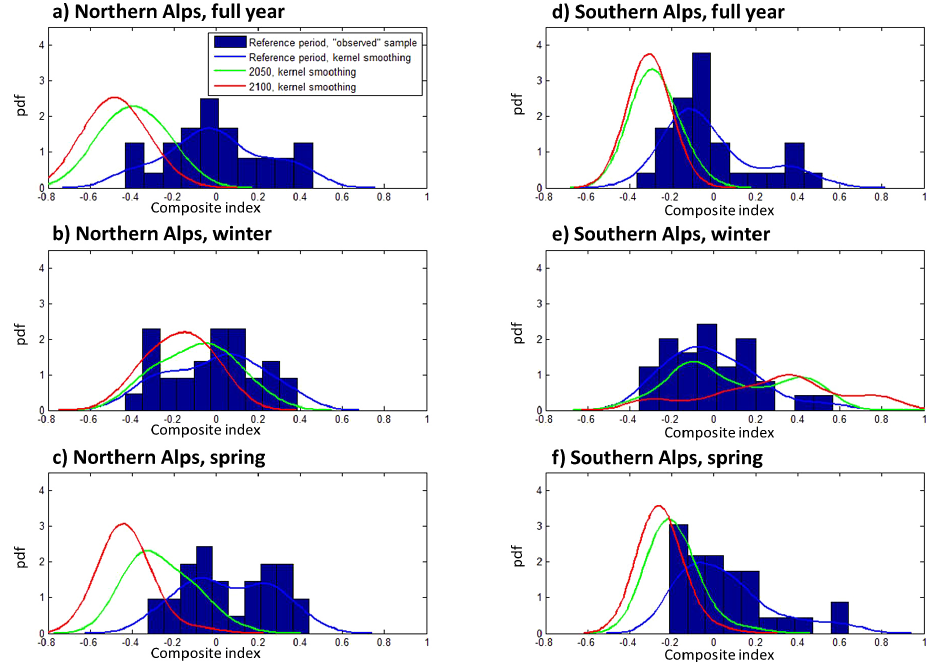
Figure 9. Probability density functions of the composite index during the reference period and the future periods 2020–2050 and 2070– 2100. Northern (left panel) and southern (right panel) French Alps during the full avalanche year (a–d) , and the winter (b–e) and spring (c–f)